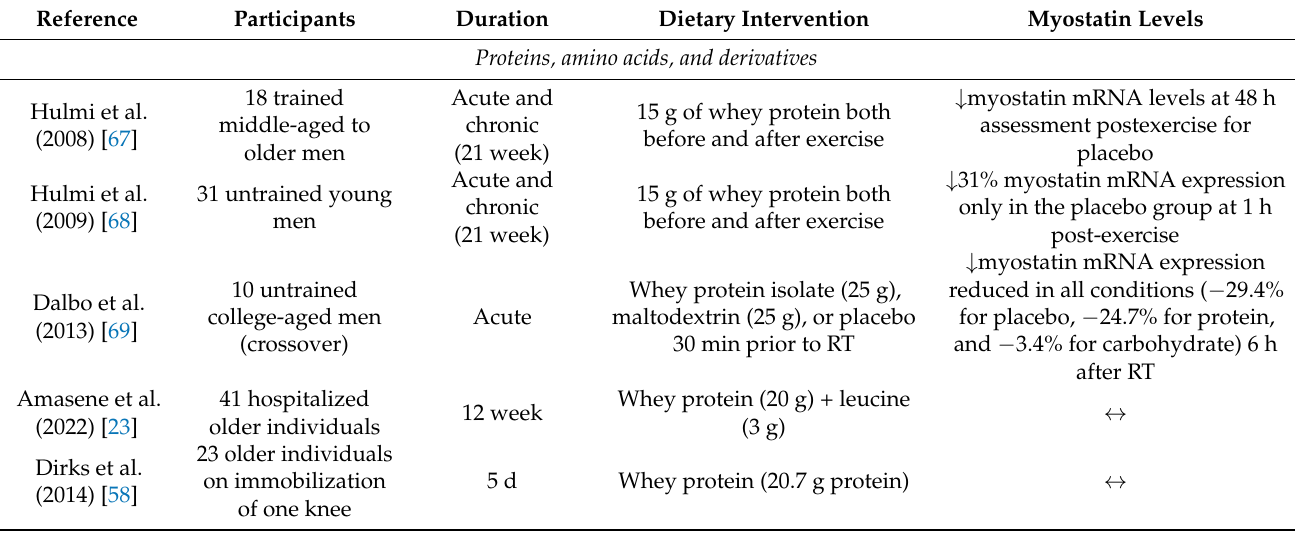
Table 2. Effects of supplements and functional foods on myostatin levels (skeletal muscle mRNA, serum, or plasma) based on